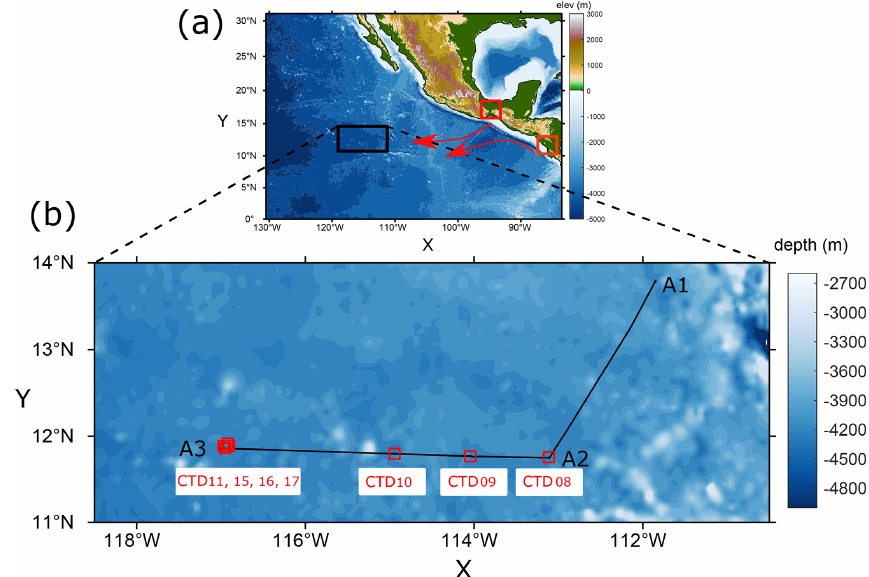
Figure 2. (a) Northeastern tropical Pacific Ocean (NETP) and orographic features of Central America. The location of Tehuantepec (TT) and Papagayo (PP) gap winds are shown as red boxes. The general trajectories of long-lived eddies in the ocean generated at TT and PP are shown as red arrows obtained from the analysis of long-lived eddies obtained from Purkiani et al. (2020). The study area and location of hydrographic survey are shown by the black box. (b) Locations of CTD stations are indicated as red boxes. Two ship transects (A1–A2 and A2–A3; black lines) were carried out to cross the eddy and investigate surface currents using the ship’s ADCP. Exact positions of CTD stations and surface currents on transects are described in Table 1. The bathymetry is shown by the blue background colors.